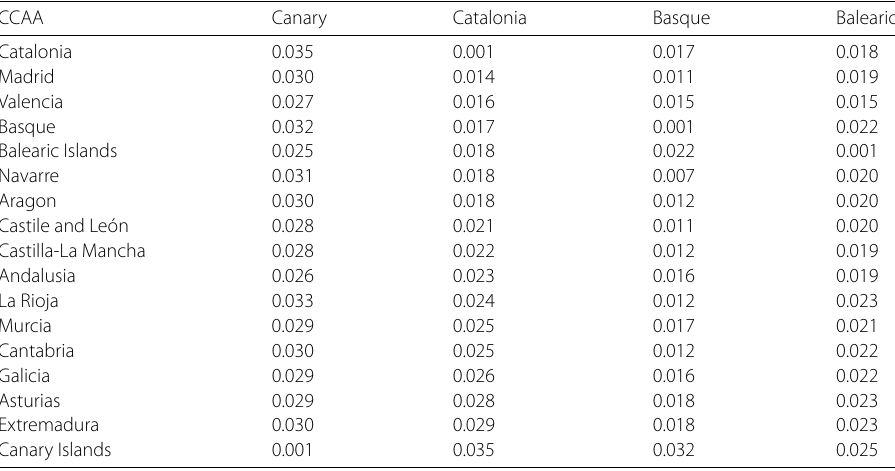
Table 3 Cosine distance between regions with strong fultlines and the rest of Spain CCAA Canary Catalonia Basque Balearic Catalonia